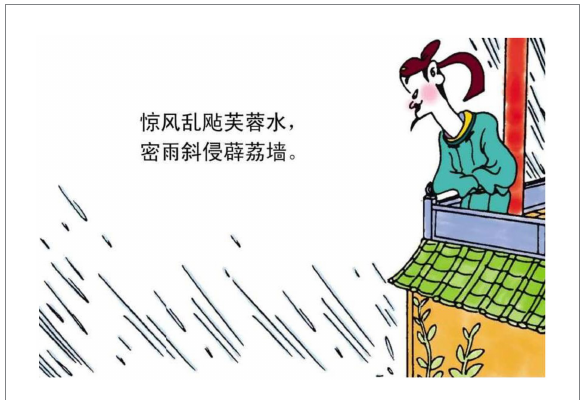
FIGURE 6 The third panel on Cai (2014, p. 116). Images reproduced with permission from Shang Dong People Press.